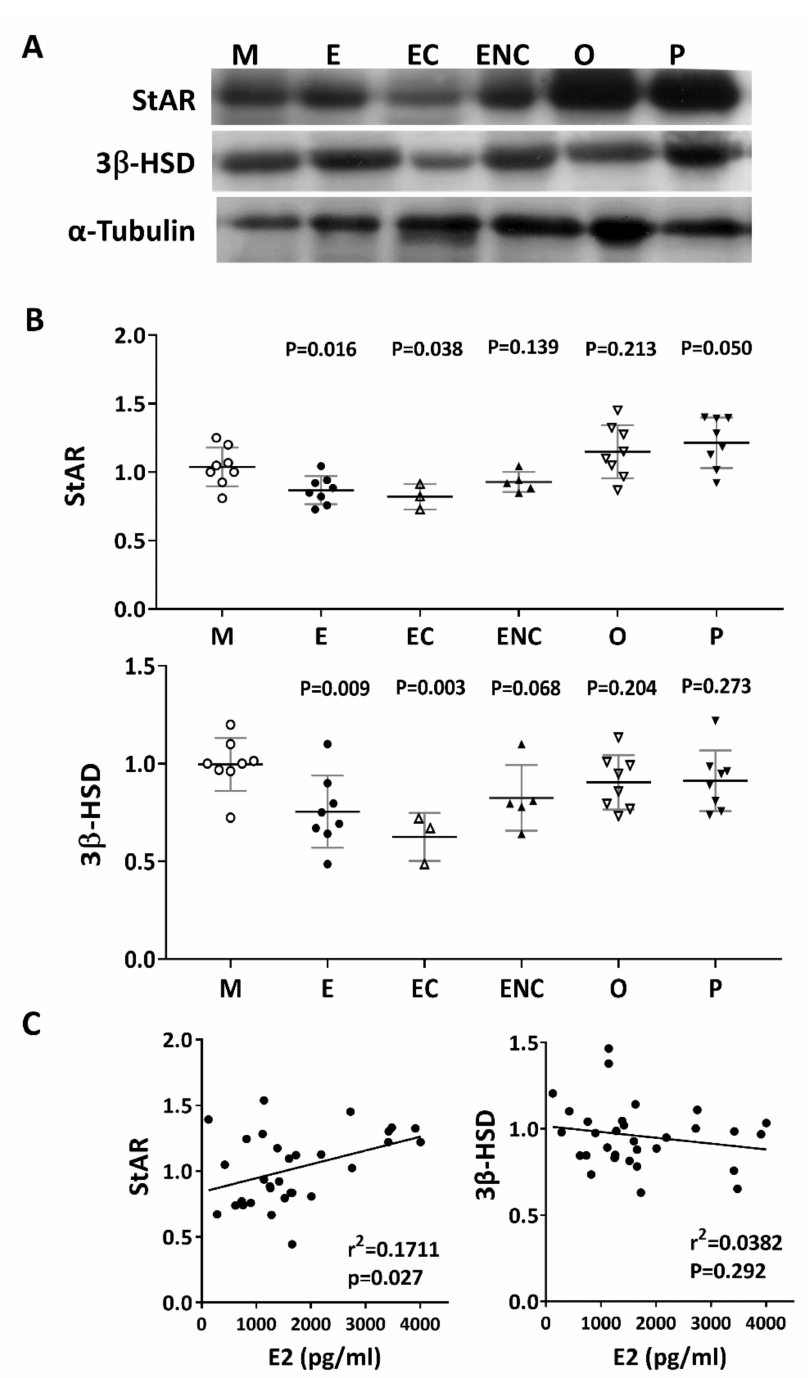
Figure 9. Alteration of key steroidogenic enzymes in various infertile groups. Steroidogenic acute regulatory protein (StAR) and 3 beta-hydroxysteroid dehydrogenase (3 β -HSD) are key steroidogenic enzymes. ( A ) Representative immunoblots reveal StAR (30 kDa) and 3 β -HSD (43 kDa) levels in granulosa cells, as determined by Western blot; α -tubulin (50 kDa) was used as an internal control. ( B ) Data quantification of StAR and 3 β -HSD. ( C ). Linear regression analysis was performed on serum E2 content with StAR or serum E2 content with 3 β -HSD in granulosa